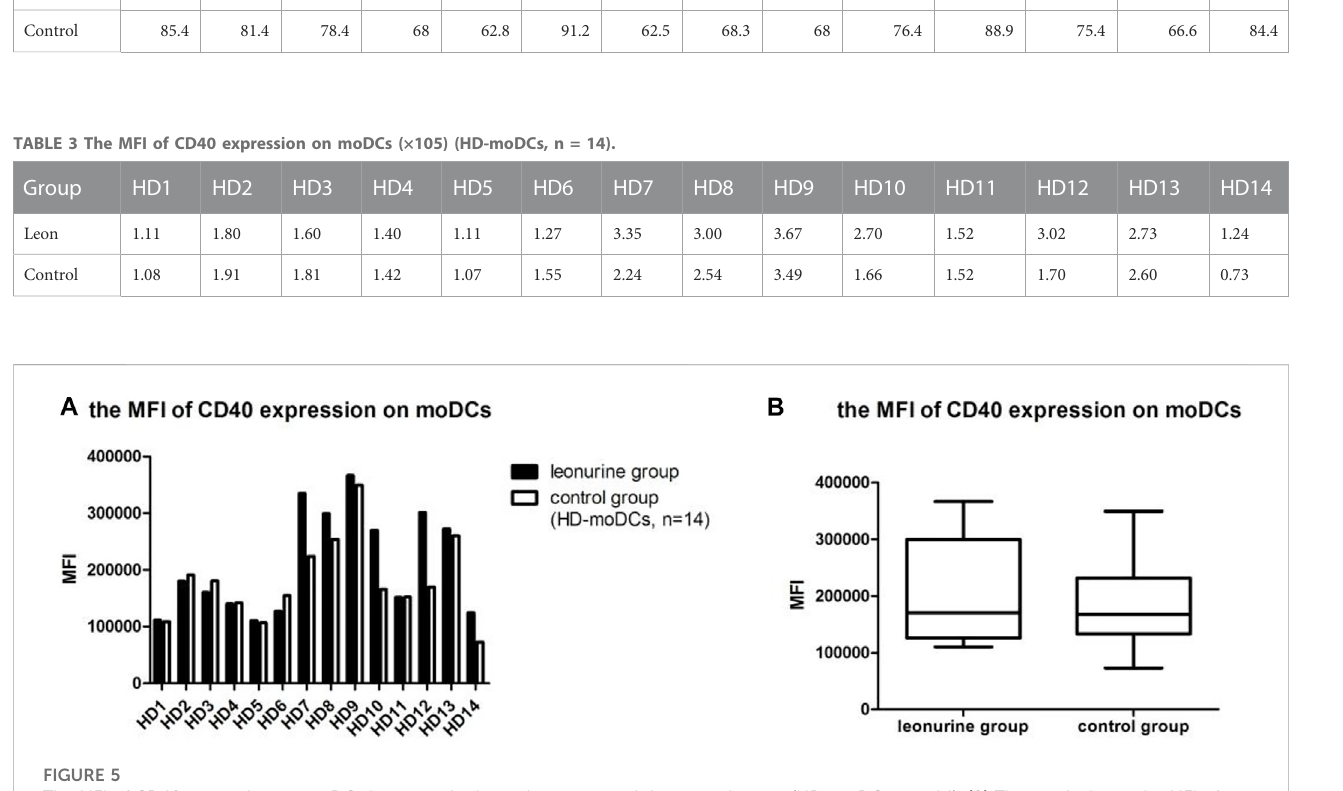
The MFI of CD40 expression on moDCs between the leonurine group and the control group (HD-moDCs, n = 14). (A) The graph shows the MFI of CD40 expression on moDCs between the leonurine group and the control group for each HD. (B) The boxplot shows that when moDCs derived from all 14 HDs were analyzed together, the MFI of CD40 expressionon moDCs was signi fi cantly higher in the leonurine group than in the control group (2.11 × 10 5 ± 0.92 × 10 5 vs. 1.81 × 10 5 ± 0.72 × 10 5 , p = 0.084, paired-sample Wilcoxon signed-rank